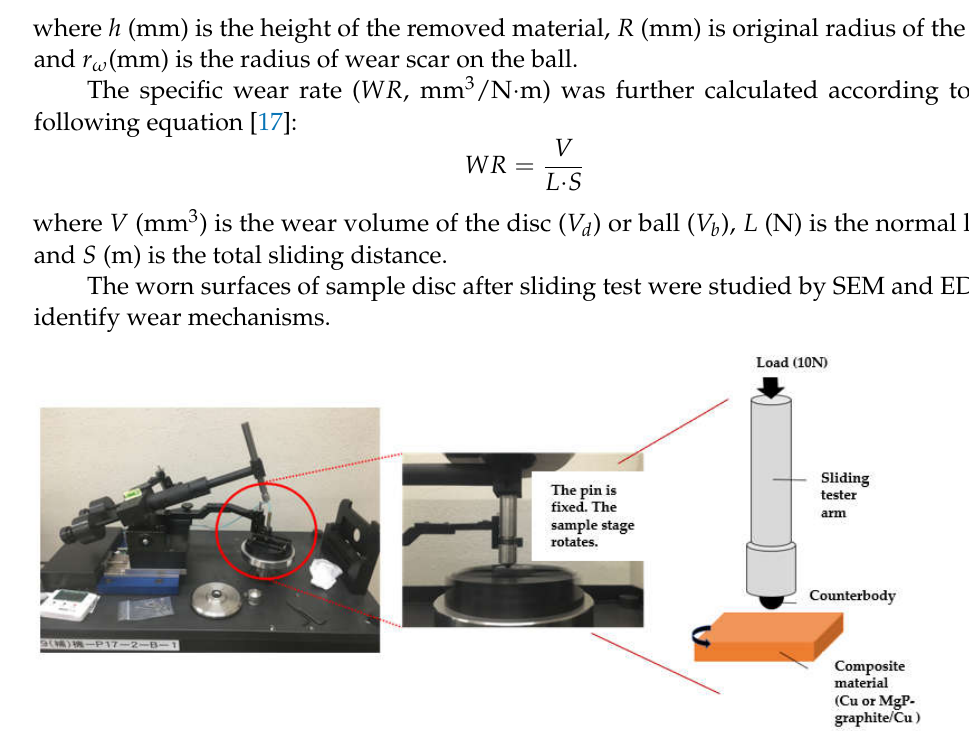
Figure 2. Schematic illustration of the pin on disc